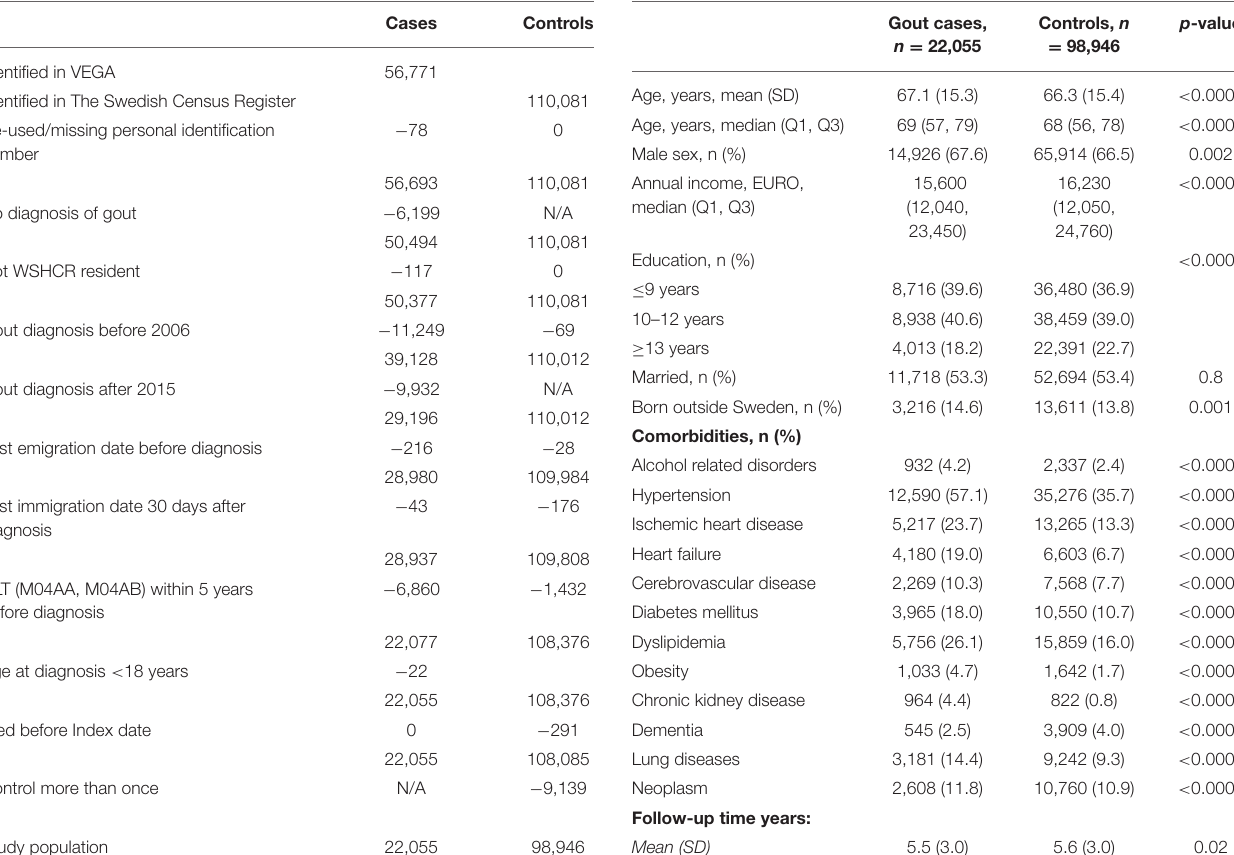
TABLE 1 | Flowchart of the study population. TABLE 2 | Baseline characteristics in gout cases and general population controls.